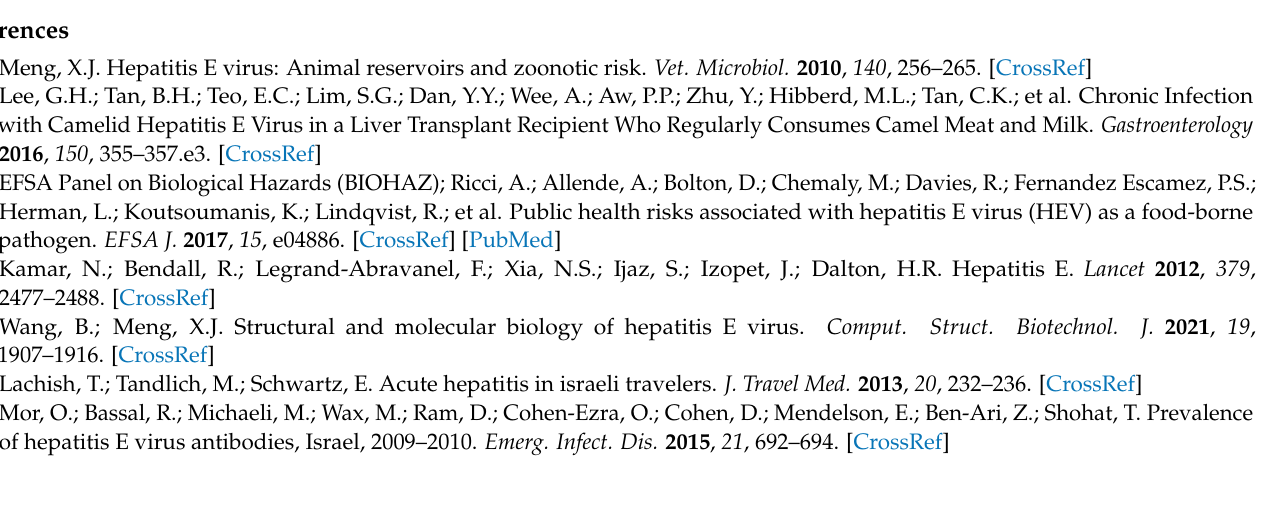
and 7, Table S2: IgG and HEV-RNA results in serum from dromedary camels ( n =